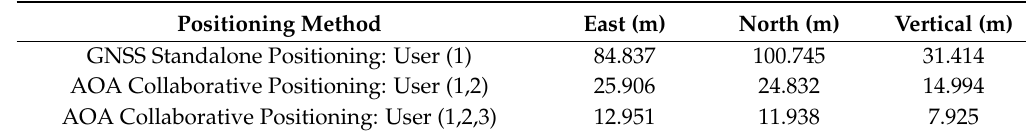
Figure 13. Positioning results of different collaboration methods. Table 4. Experimental statistics